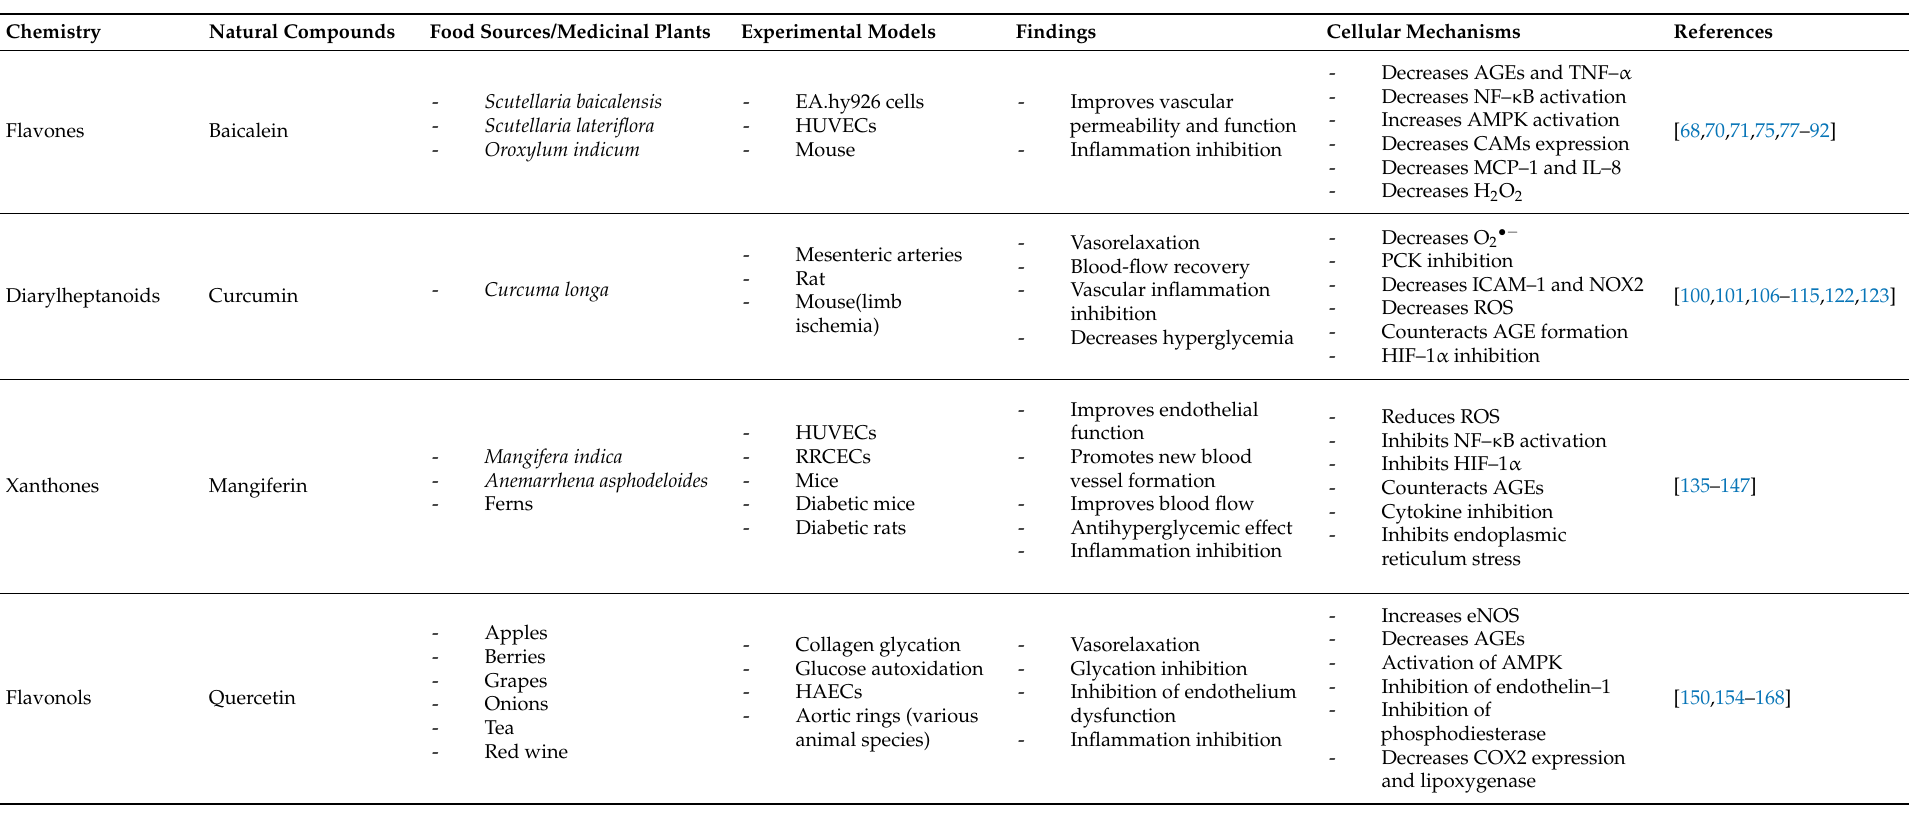
Table 1. Plant-derived polyphenols with potential activity in preventing or improving cardiovascular diseases and, thus, also PAD: in vitro and in vivo studies using various cellular or animal